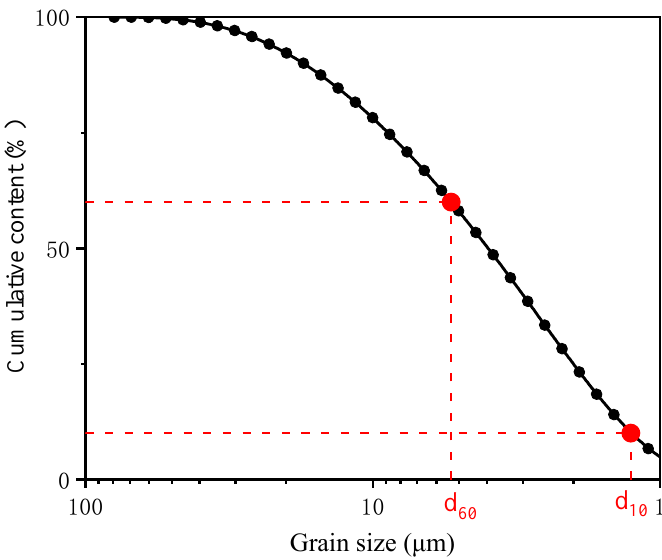
Figure 1. The gradation curve of the sample tailings. Table 1. Sample tailings XRF analysis and datasheet.